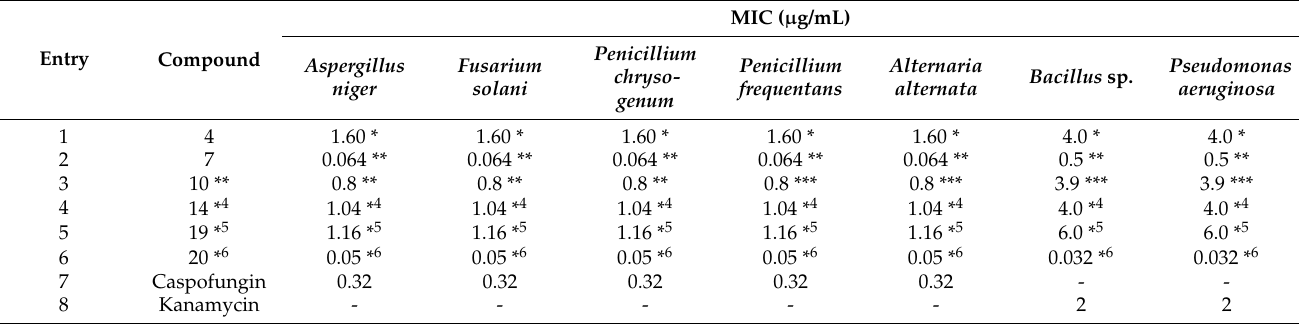
Table 1. In vitro antifungal and antibacterial activities of compounds 4 , 7, 10 , 14 , 19. and 20